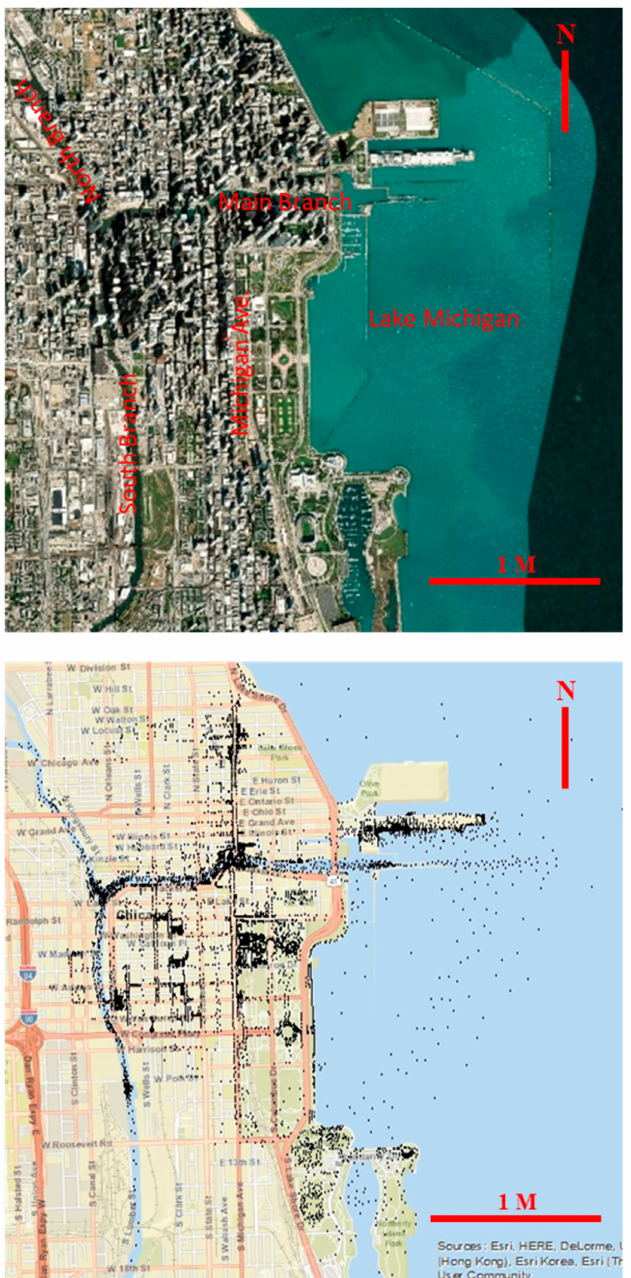
Figure 1. Top map shows an aerial view of downtown Chicago. Bottom map shows locations of uploaded photographs to social media sites with a street map in the